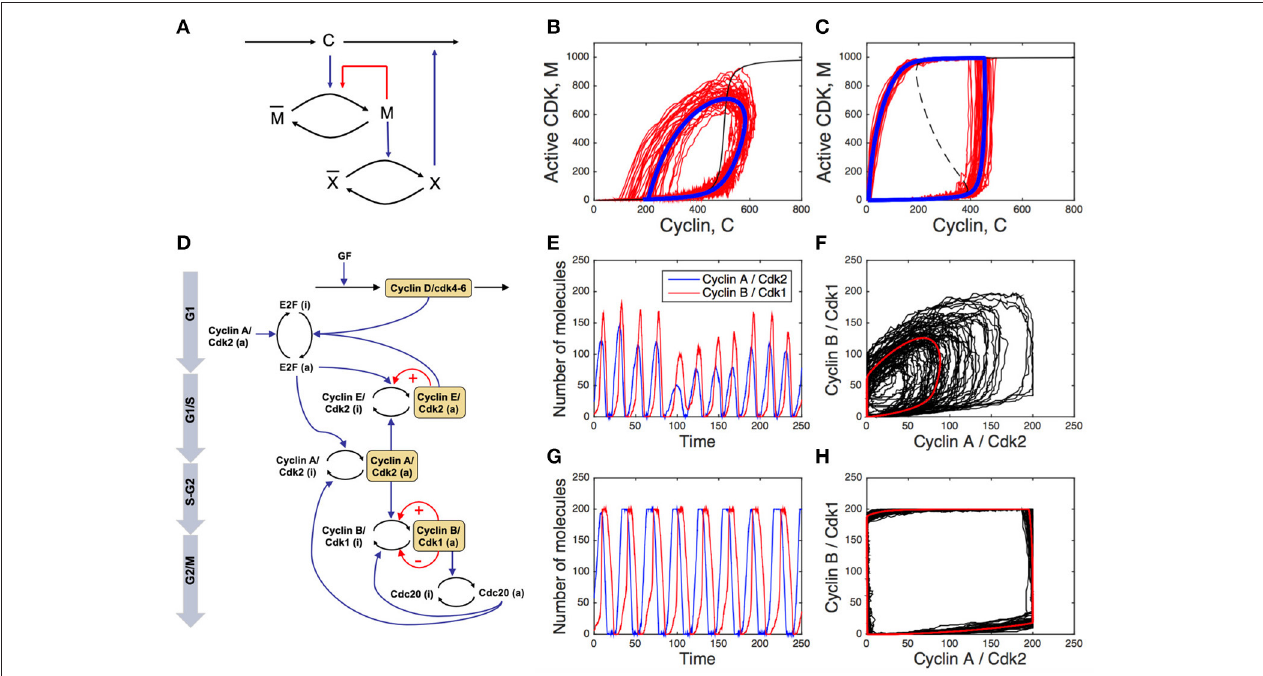
FIGURE 2 | Impact of positive feedback loops on the cell cycle robustness. (A) Scheme of a toy model for embryonic cell cycle (C, cyclin; M, CDK; X, protease), with positive feedback (PF) loop denoted by the red arrow. (B,C) Deterministic (blue curves) and stochastic (red curves) limit cycle obtained without (B) or with (C) PF loop (see Gonze and Hafner (2010) for details). The dashed, black curve is the steady state of M as a function of C obtained when C is kept constant. (D) Scheme of the skeleton model for the mammalian cell cycle. The red arrows indicated the PFs. (E,G) Stochastic temporal evolution of cyclin E/CDK2 and cyclin B/CDK1 in the absence (E) or presence (G) of PF driving the G1/S and G2/M transitions of the cell cycle. (F,H) Deterministic (red curves) and stochastic (black curves) limit cycle oscillations in the cyclin B/CDK1 vs. cyclin A/CDK2 plot in the absence (F) or presence (H) of PF loops. See Gérard et al. (2012) for details.